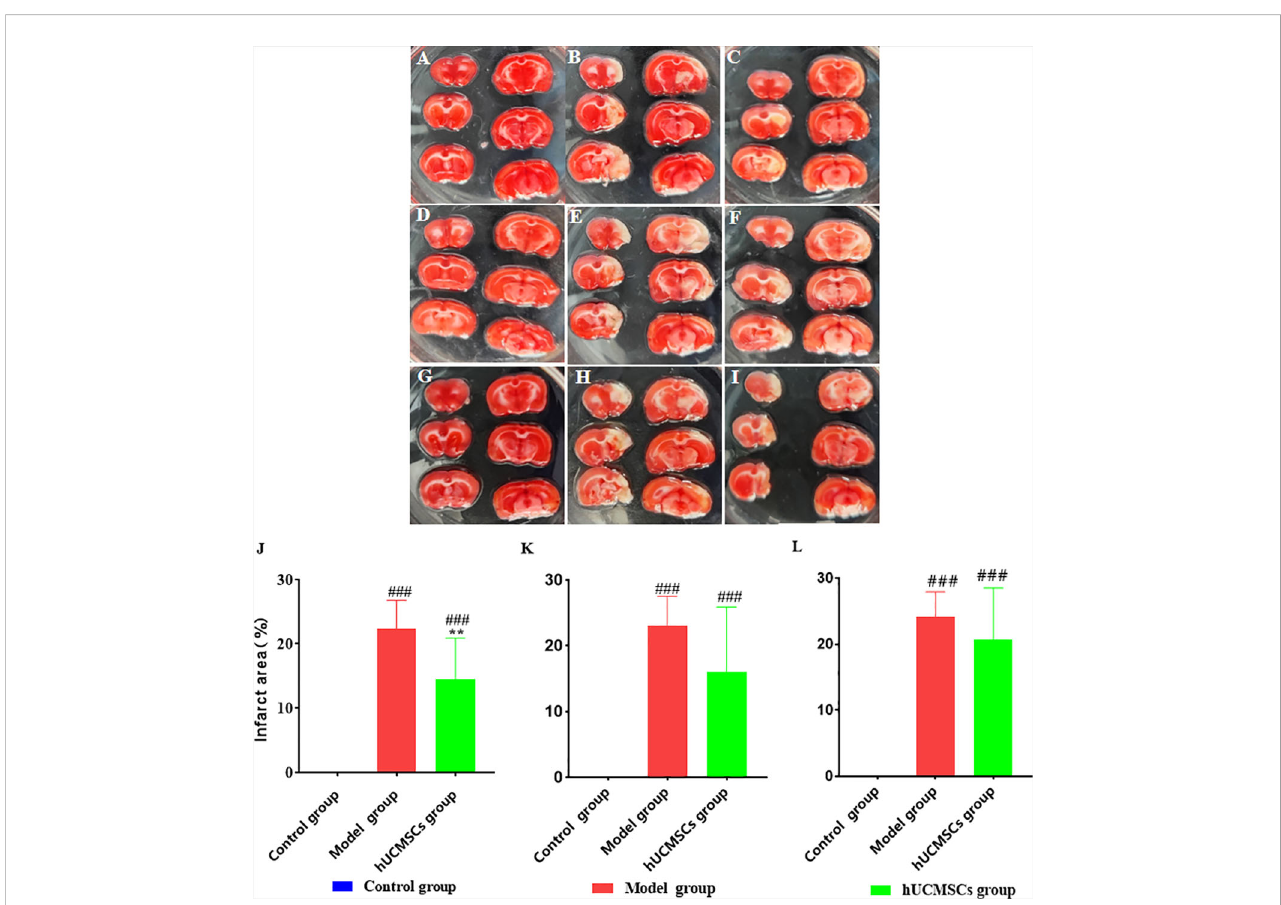
FIGURE 8 Effect of hUCMSCs administration on the size of the cerebral infarction area of MCAO rats at different administration time points. The fi gures show the results of the TTC staining of the MCAO rats ’ brain tissue 28 days after administration. The white area means necrotic area, (A – C) The TTC staining of the control group, model group, and hUCMSCs treatment group after administration on d4; (D – F) The TTC staining of the control group, model group, and hUCMSCs treatment group after administration on d7; and (G-I) The TTC staining of the control group, model group, and hUCMSCs treatment group after administration on d14; (J – L) The proportions of cerebral infarction area as evaluated by TTC after administration on d4, d7, and d14 post-modeling. Data are presented as mean ± SD. ### P<0.001 vs control group; **P<0.01 vs model